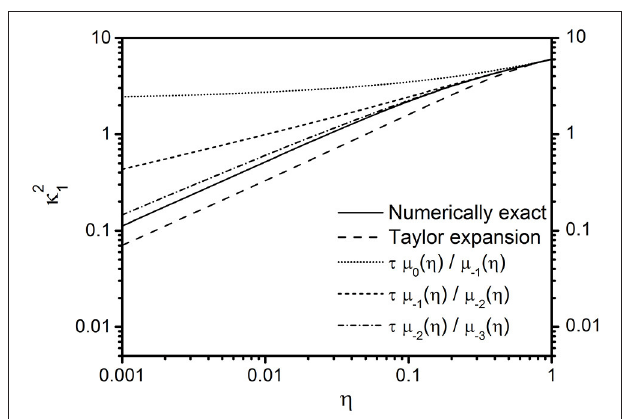
FIGURE 3 | Dependence of successive moment ratios on the volume fraction for spherical magnetic objects. The ratio of successive moments τ µ n ( η ) /µ ( n 1) ( η ) = l − n ( η ) / l ( n 1) ( η ) in dependence on volume fraction η is − − + − + obtained from Equation (46) [functions l n ( η ) are given in Equation (50)]. The − numerically exact eigenvalue (solid line) can be obtained by solving Equation (17). An approximate solution for κ 2 1 (dashed line), based on a Taylor expansion, is given in Equation (A3) in Appendix A. For η 1, all graphs → asymptotically converge to the value κ 2 1 6. A visualization of =